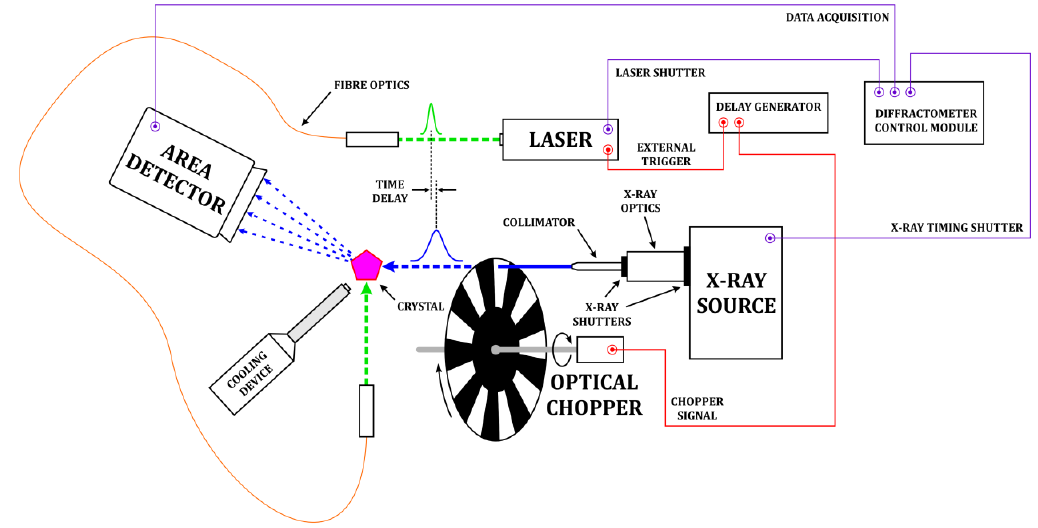
Figure 7. Schematic representation of an in-house photocrystallography setup including a classical CCD detector and an X-ray chopper [88].